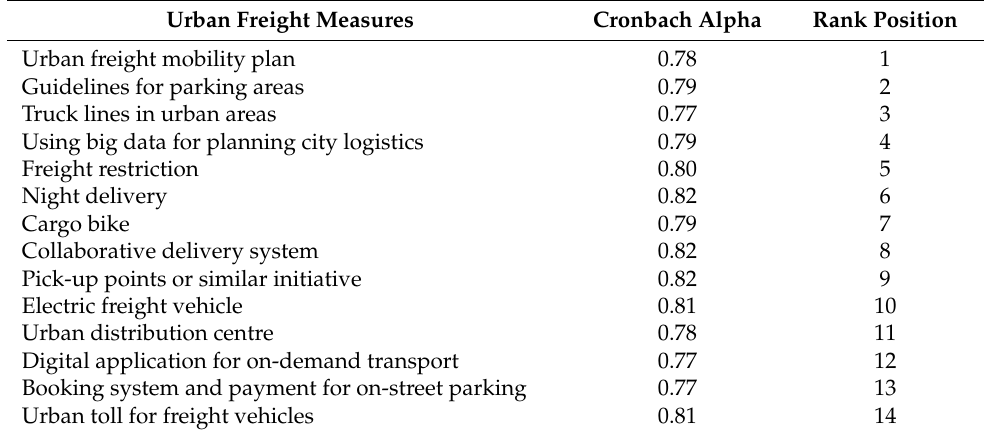
Table 1. Evaluation of urban freight measures by logistics operators’